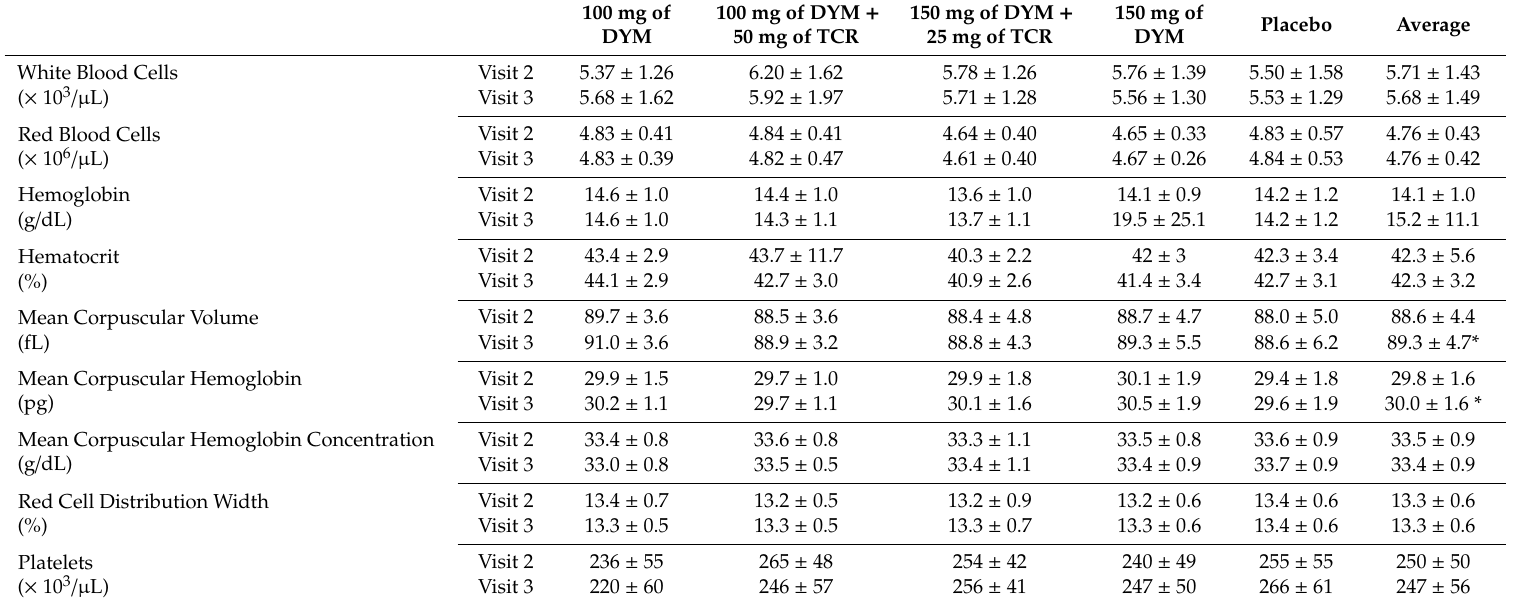
Table 3. Group ( n = 25 per group) and average complete blood count comparisons between Visits 2 and 3.